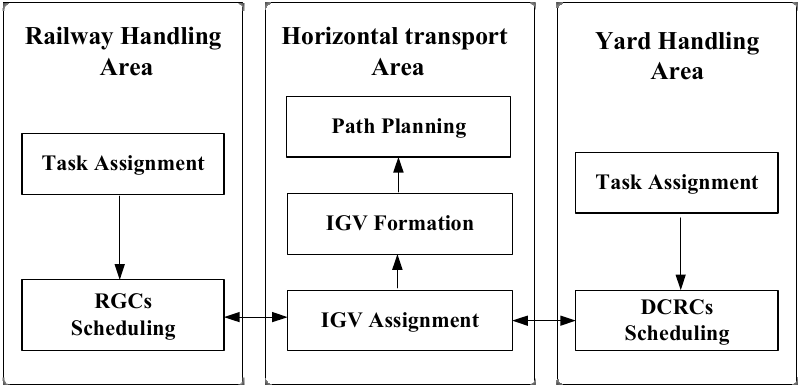
Figure 2. Analysis of loading and unloading equipment and problems between railway yards and yards.